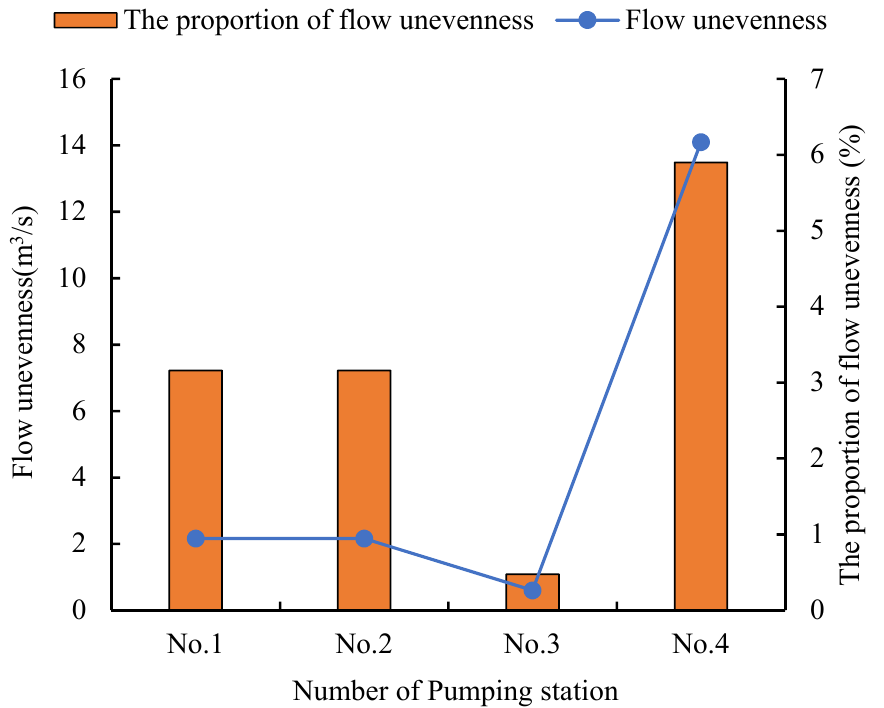
Figure 5. Unevenness of each pumping station and corresponding proportion to the design flow under the daily average head of 7.8 m.